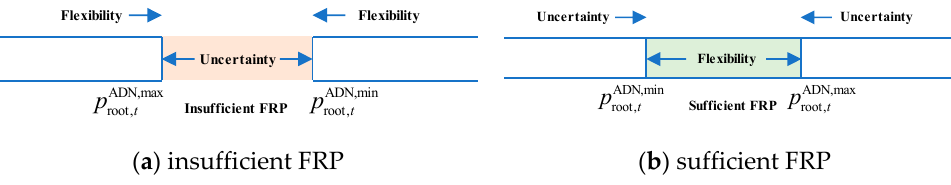
Figure 3. Different solutions of root node power Using RO.